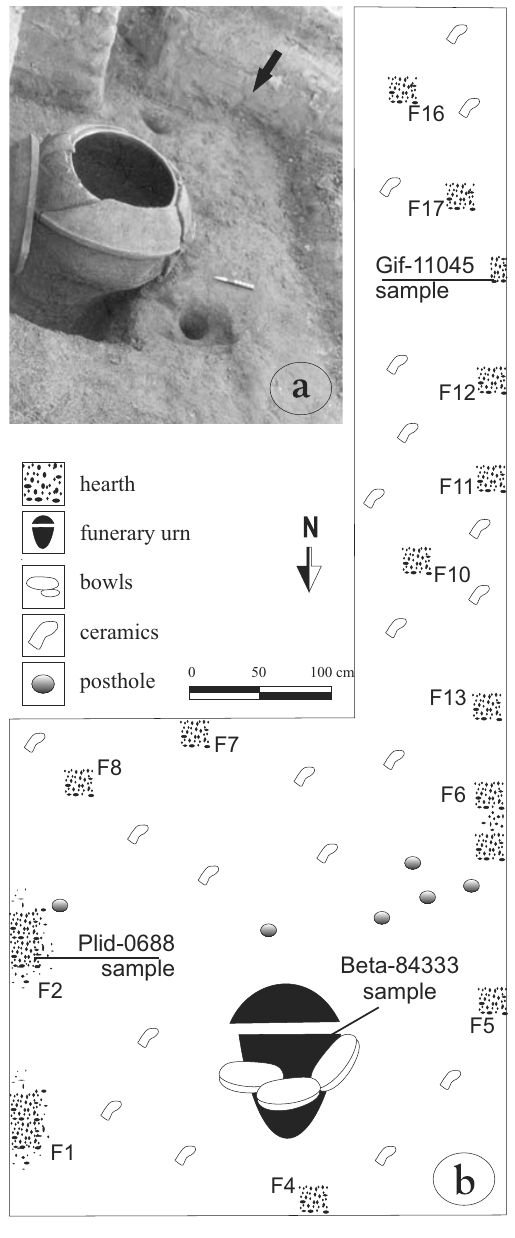
Fig. 3 – Morro Grande site Archaeological Sector 2. (a) View of the excavation area. The arrow indicates the ceremonial hearth from which sample Plid-0688 was taken; (b) Excavation plan situating the excavated hearths, the samples dated in this work (Gif-11045, Plid- 0688), and a previously dated sample (Beta-84333, Buarque 1995). Hearths F1 to F8, containing high proportions of bark, are interpreted as elements of the mortuary ritual. Hearths F10 to F17, containing few or no bark fragments, are interpreted as domestic features (M. Beauclair, unpublished